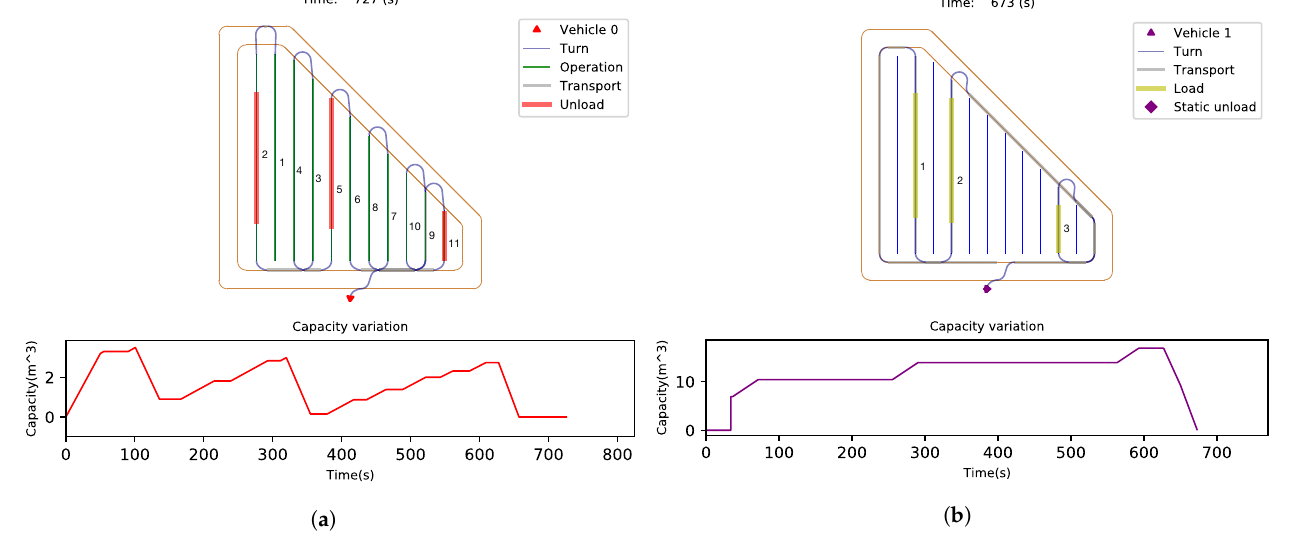
Figure 7. ( a ) Primary unit route. ( b ) Service unit route. Coverage path planning examples for the primary field area only. Three on-the-go unloadings are displayed for the simplified field shape. ( a ) Illustration of the track sequence of PU, where its bin level is illustrated in the diagram below the route example. Time zero is where the PU enters the field, and 727 s is the positioning time of the PU in the route example ( J ), i.e., the end of harvest operation. ( b ) Illustration of the the track sequence of one SU, where the filling level of the transport unit is illustrated in the diagram below the route example. Depot unloading ( ) takes places where the filling level begins decreasing and ends at 673 s. (cid:5) Note that the time is not synchronised between the sub-figures ( a , b